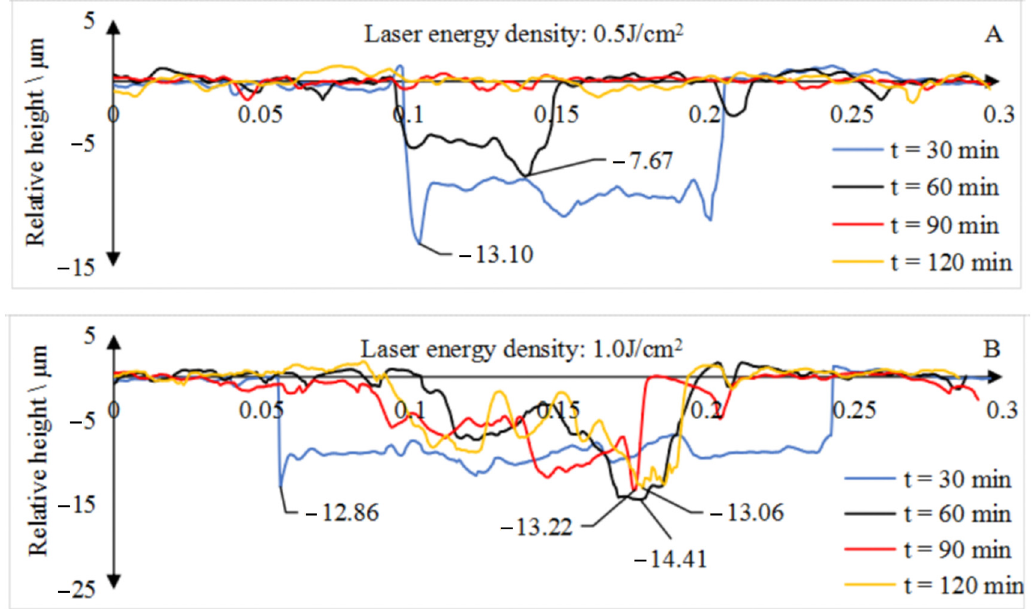
Figure 13. Damage pits profile after laser irradiation with different oxidation time. The laser energy density in ( A ) is 0.5 J/cm 2 ; ( B ) is 1.0 J/cm 2 . Table 9. Width and depth of laser damage pit of oxidation time group. Oxidation